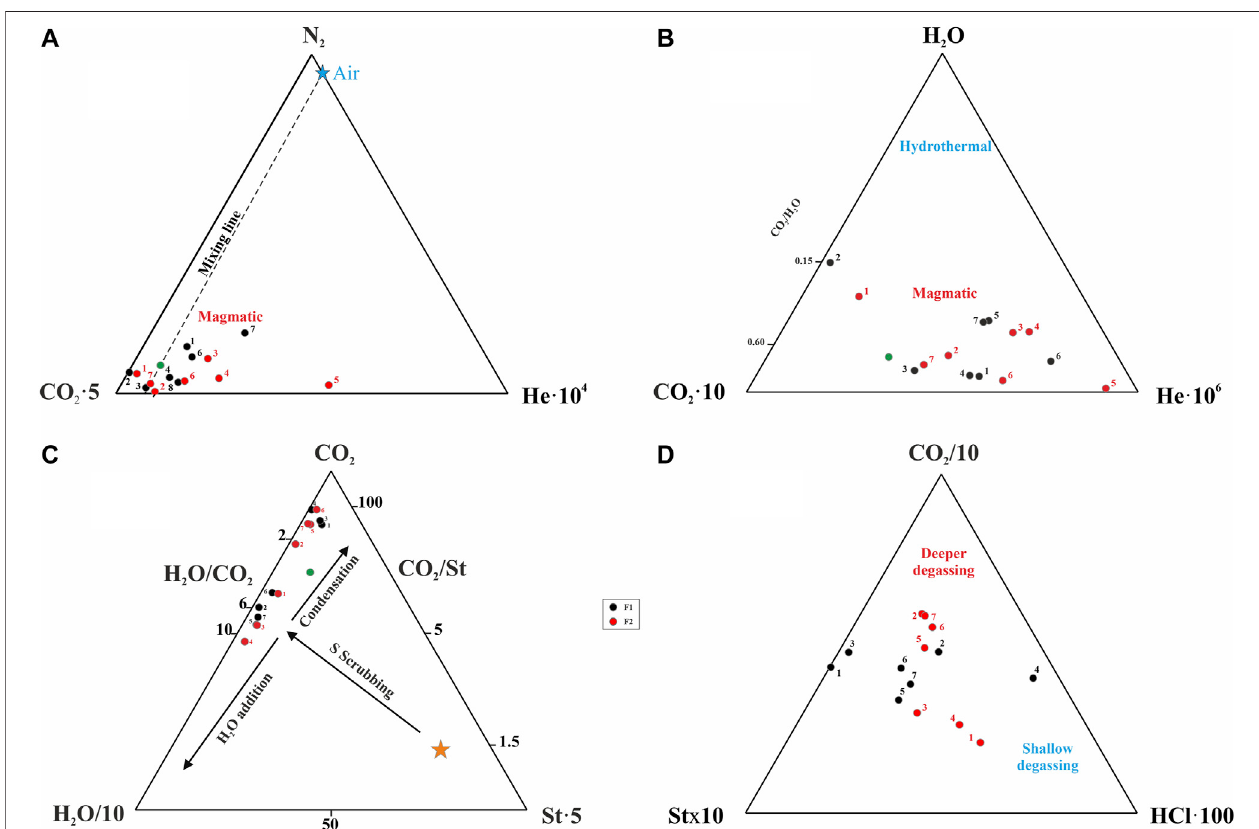
FIGURE4| Ternary chemical compositiondiagrams for Picodo Fogo fumarole samples: (A) CO 2 -N 2 -He, (B) CO 2 -H 2 O-He, (C) CO 2 -H 2 O-St and (D) CO 2 -St-HCl. The green circle shows the mean values of composition summit fumaroles of Pico do Fogo from Aiuppa et al. (2020). The orange star indicates composition of the 2014 – 2015 Fogo eruptive plume from Hernández et al. (2015). Codes from Table 1 .